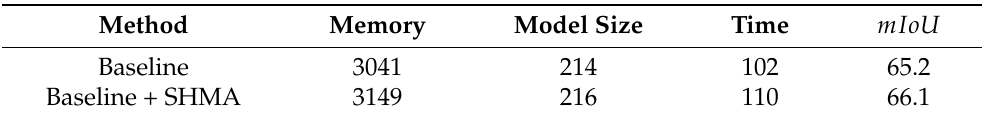
Table 5. Results of model complexity. The units for memory, model size and time are MB, MB and